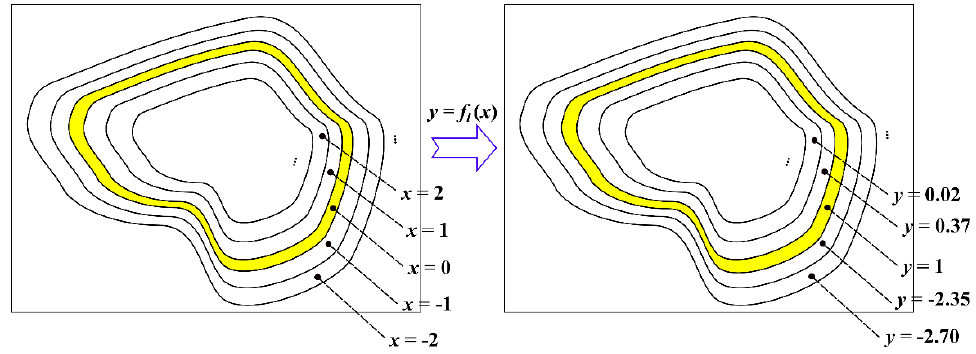
Figure 3. Example of the application of the function f l on the layers map (with c 1 = c 2 = 1, c 3 = e ). The object contour is outlined in yellow.